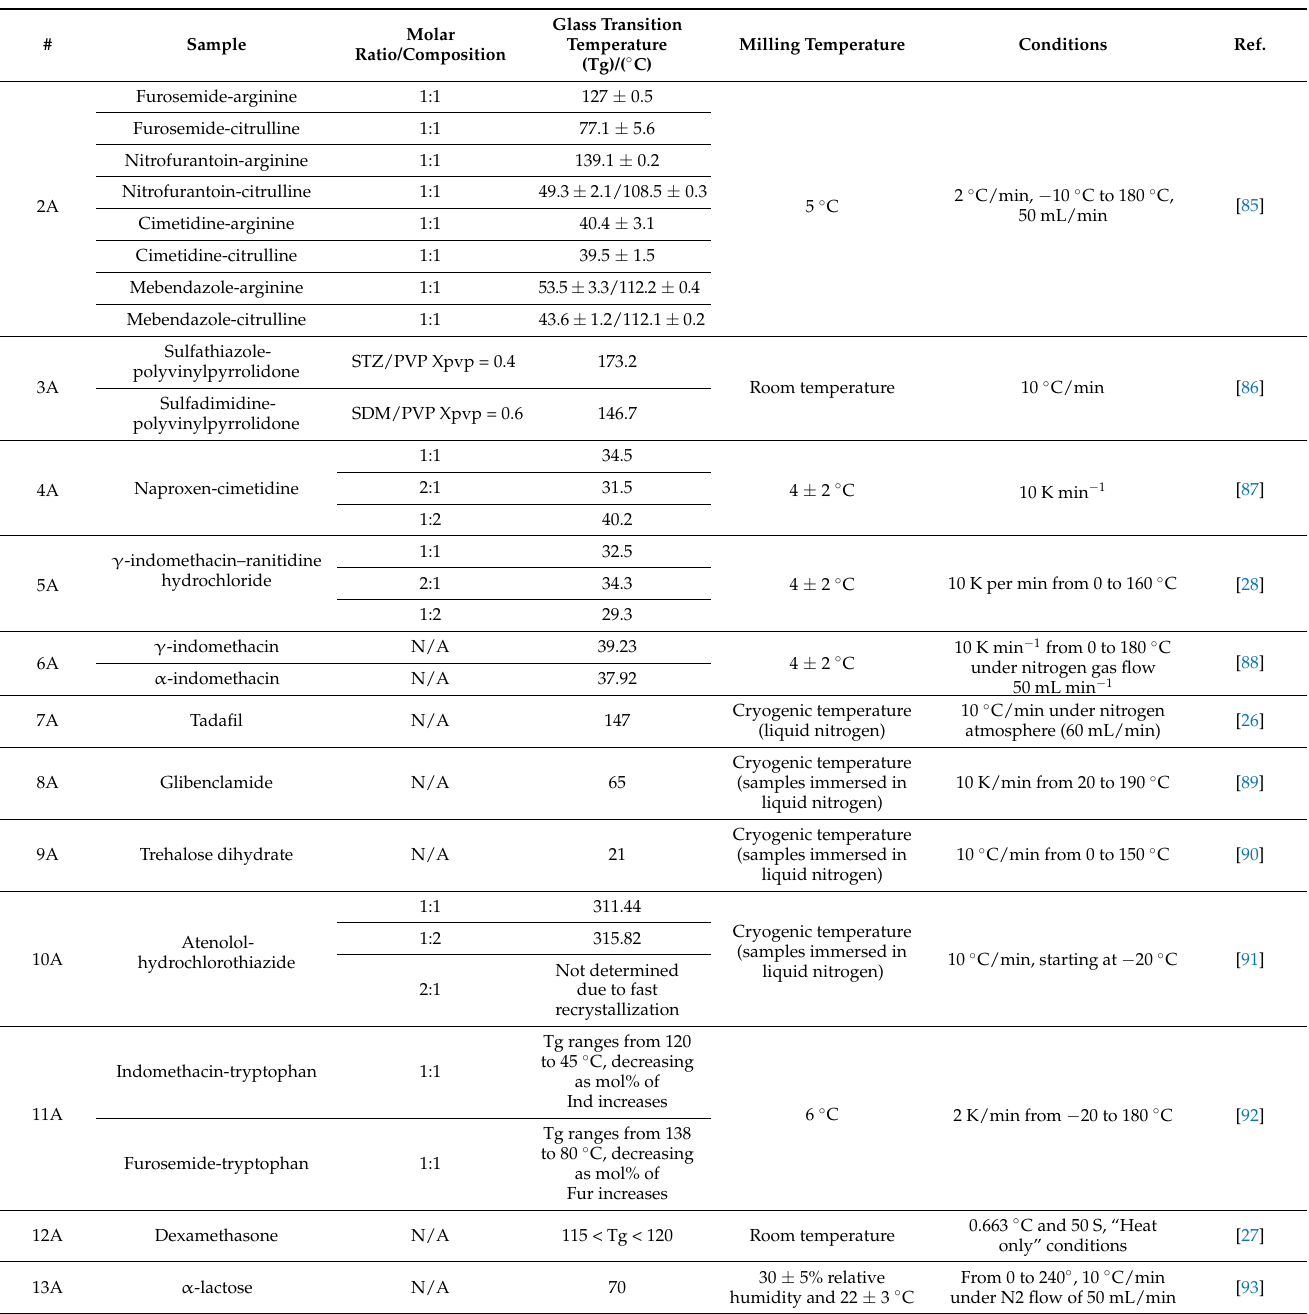
Table 9. Overview of thermal characterization (DSC) of amorphous samples obtained by ball